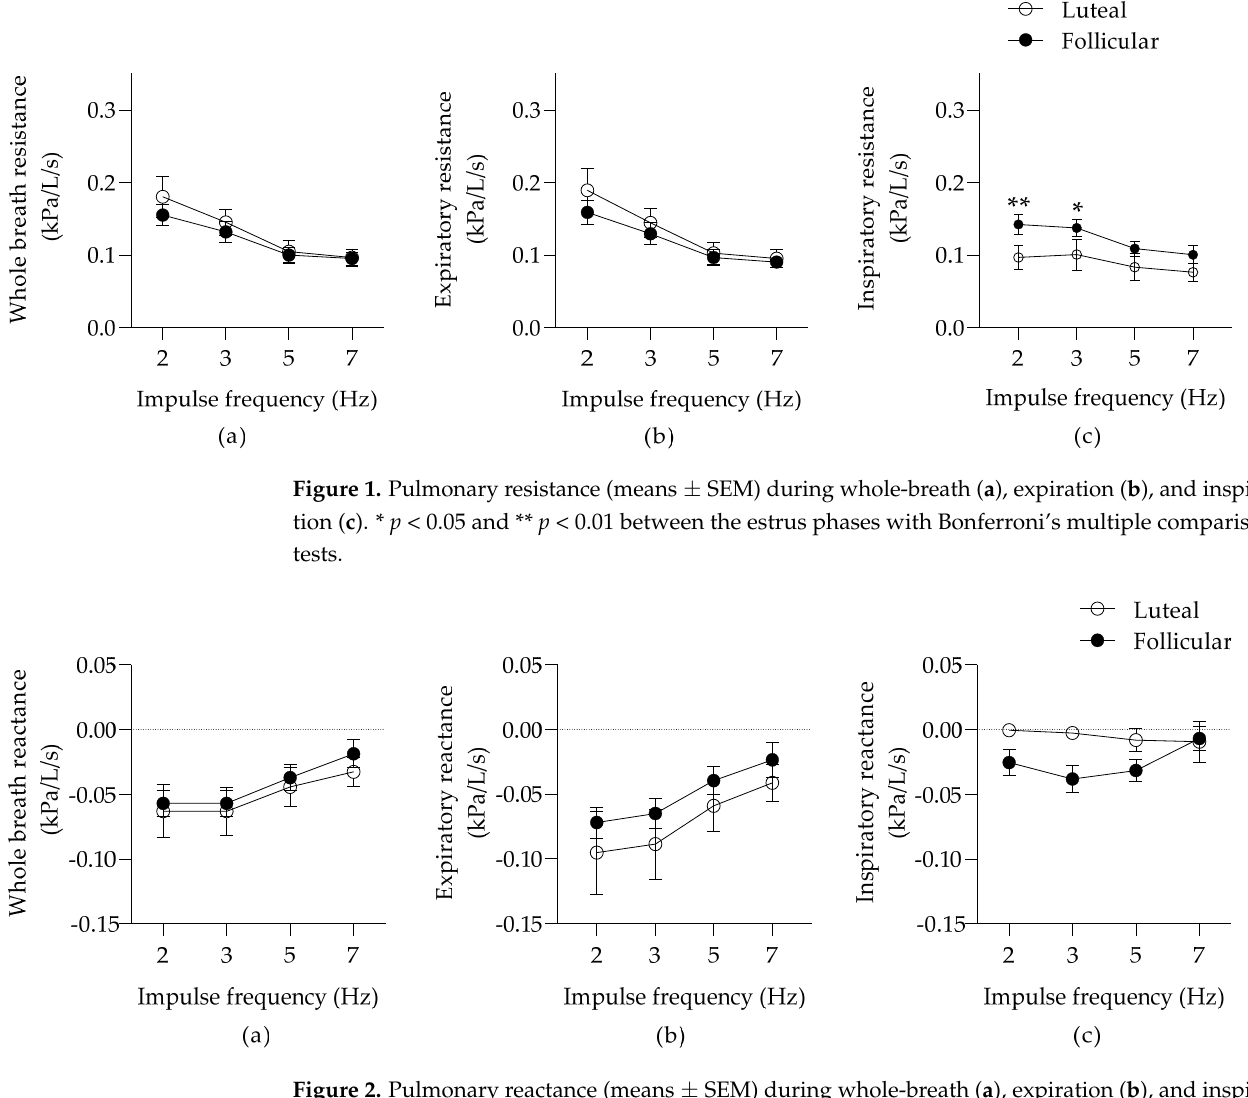
Figure 2. Pulmonary reactance (means ± SEM) during whole-breath ( a ), expiration ( b ), and inspiration ( c ).